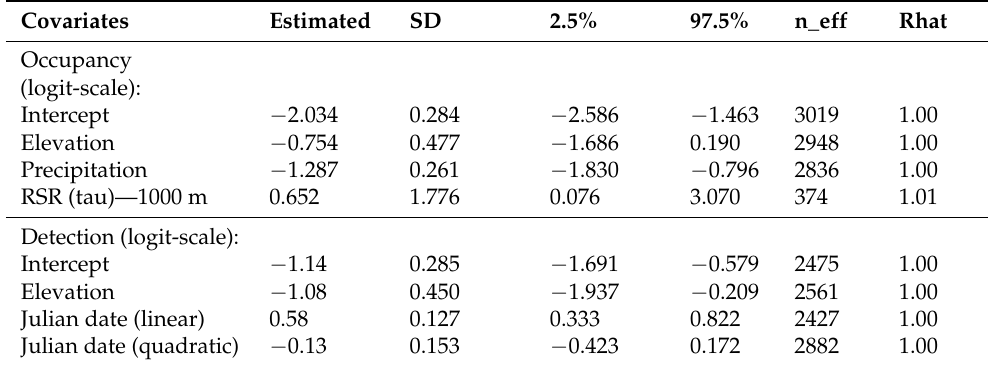
Table A2. Output summary from the best model ( ψ (intercept + elevation + precipitation + RSR-1000); ρ (intercept + elevation + Julian day + Julian day 2 )) of Venezuelan troupial ( Icterus icterus ) in Puerto Rico. RSR = restricted spatial regression. Runtime: 2.722